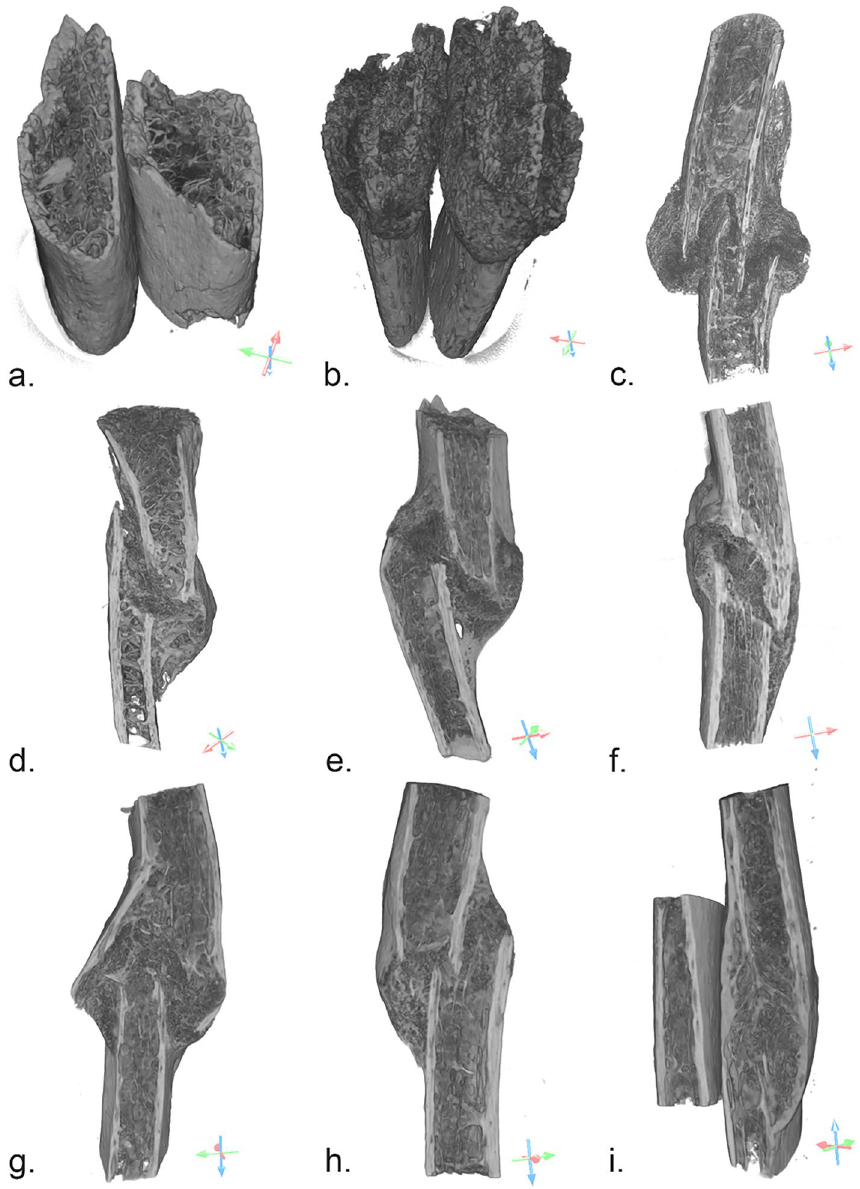
Figure 1. Selected areas of interest in the nine bone samples; ( a ): sample N1 , 8 days old, areas of interest 1 and 3 with no signs of bone healing and sharp fracture margins next to the bony trabeculae, areas 2 and 4: healthy bone; ( b ): sample N5 , 28 days old, areas of interest 2 and 3 with woven non-remodeled bone close to fracture line, areas 1 and 4: healthy bone; ( c ): sample N4 , 42 days old, areas of interest 2 and 3 with exaggerated bulging callus accumulating at the periphery, areas 1 and 4: healthy bone; ( d ): sample N3 , 72 days old, areas of interest 2 and 3 with exuberant woven bone formation, areas 1 and 4: healthy bone; ( e ): sample N2A , 86 days old, areas of interest 2 and 3 with denser woven bone, areas 1 and 4: healthy bone; ( f ): sample N2B , 86 days old, areas of interest 2 and 3 with signs of advanced healing, including lamellar oriented trabeculae and a smoother appearance of the cortical regions, areas 1 and 4: healthy bone; ( g ): sample N2C , 86 days old, areas of interest 2 and 3 with lamellar and woven bone, areas 1 and 4: healthy bone; ( h ): sample N2D , 86 days old, areas of interest 2 and 3 with dense woven callus and complete bridging on the left side, areas 1 and 4: healthy bone; ( i ): sample N6 , 2 years old, areas of interest with 2 and 3 remodeled lamellar bone, areas 1 and 4: healthy bone.